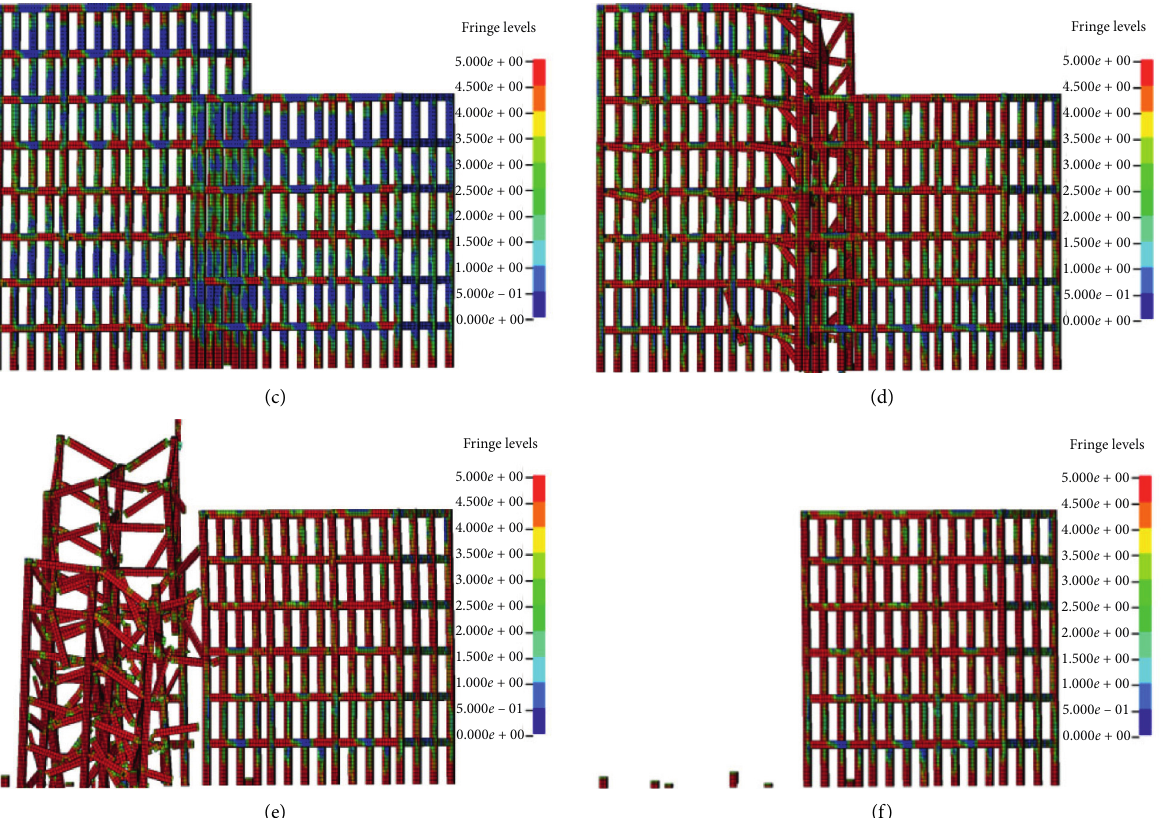
Figure 11: Collapse and impact process corresponding to weak column GK-3 (PGA � 0.62g): (a) t � 0.00 s; (b) t � 1.34s; (c) t � 8.11s; (d) t � 9.00s; (e) t � 11.00s; and (f) t � 15.00s.